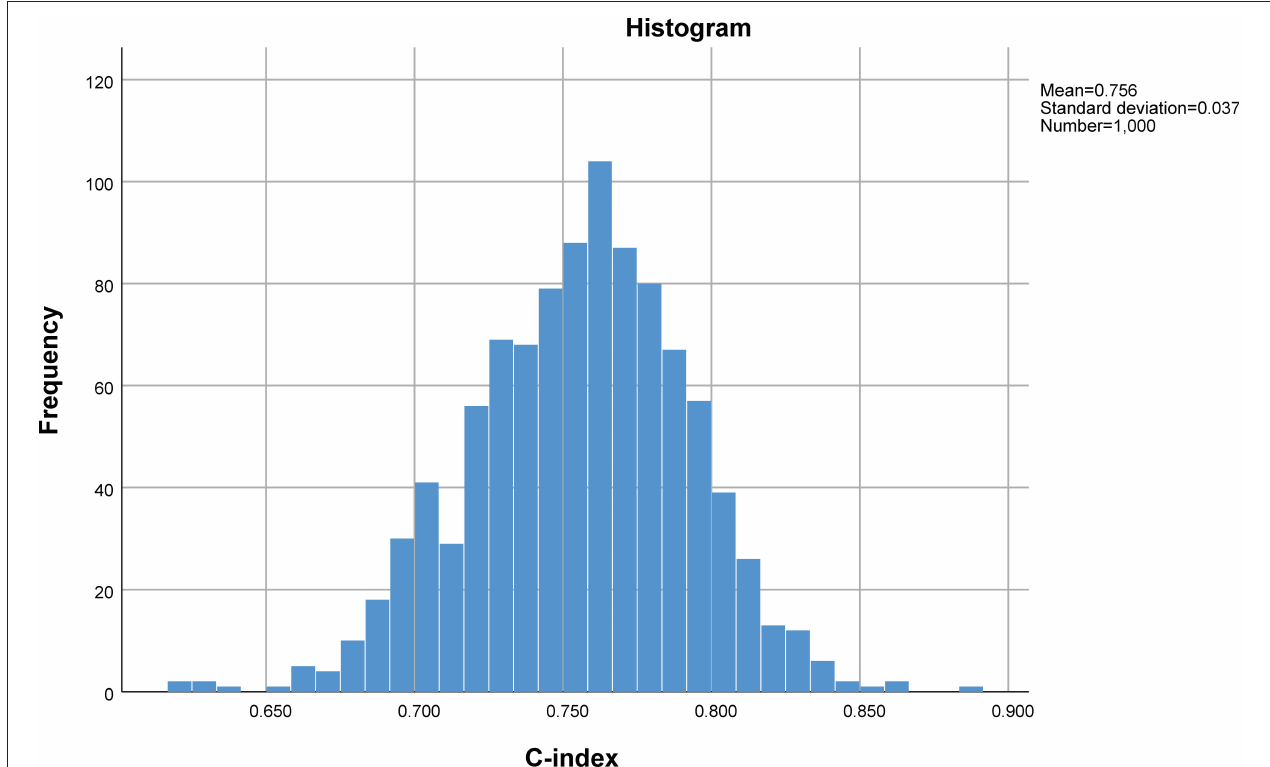
FIGURE 4 | C-index of internal validation of 1,000 bootstrapping